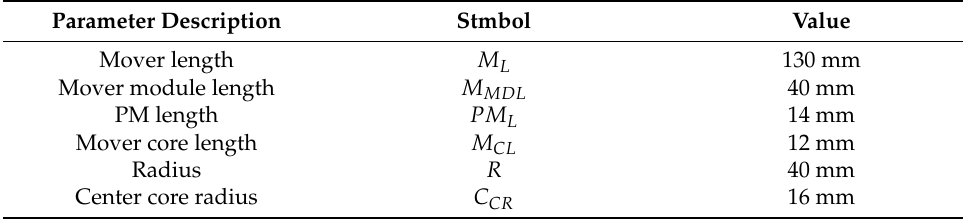
Table 1. Parameter details of proposed